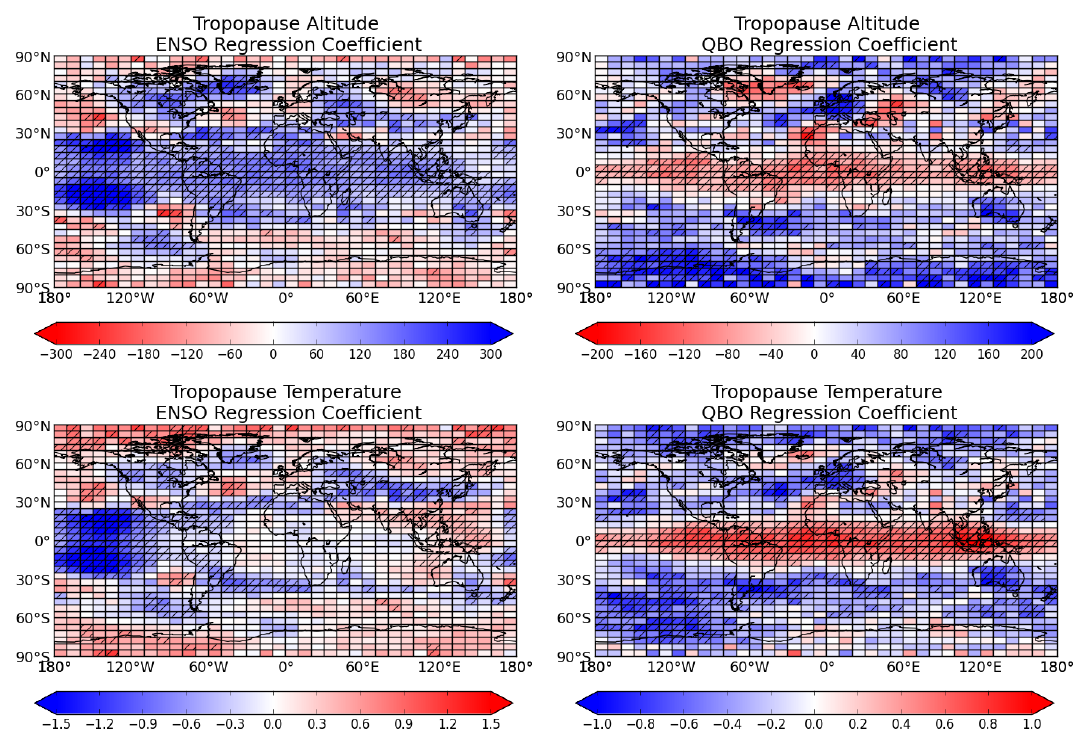
Figure 8. ENSO (left) and QBO (right) regression coefficients for the regression of tropopause altitude (top) and temperature (bottom). Units are meters ( H T change) per kelvin or kelvin ( T T change) per kelvin for ENSO regression coefficients and meters ( H T change) per 10 (ms − 1 ) or kelvin ( T T change) per 10 (ms − 1 ) for QBO regression coefficients. Hatched areas denote areas statistically significant at a significance level ≥ 95%. Color bars of the ENSO and QBO coefficients are reversed for the regression of tropopause altitude and temperature for easier comparison (higher tropopauses are generally